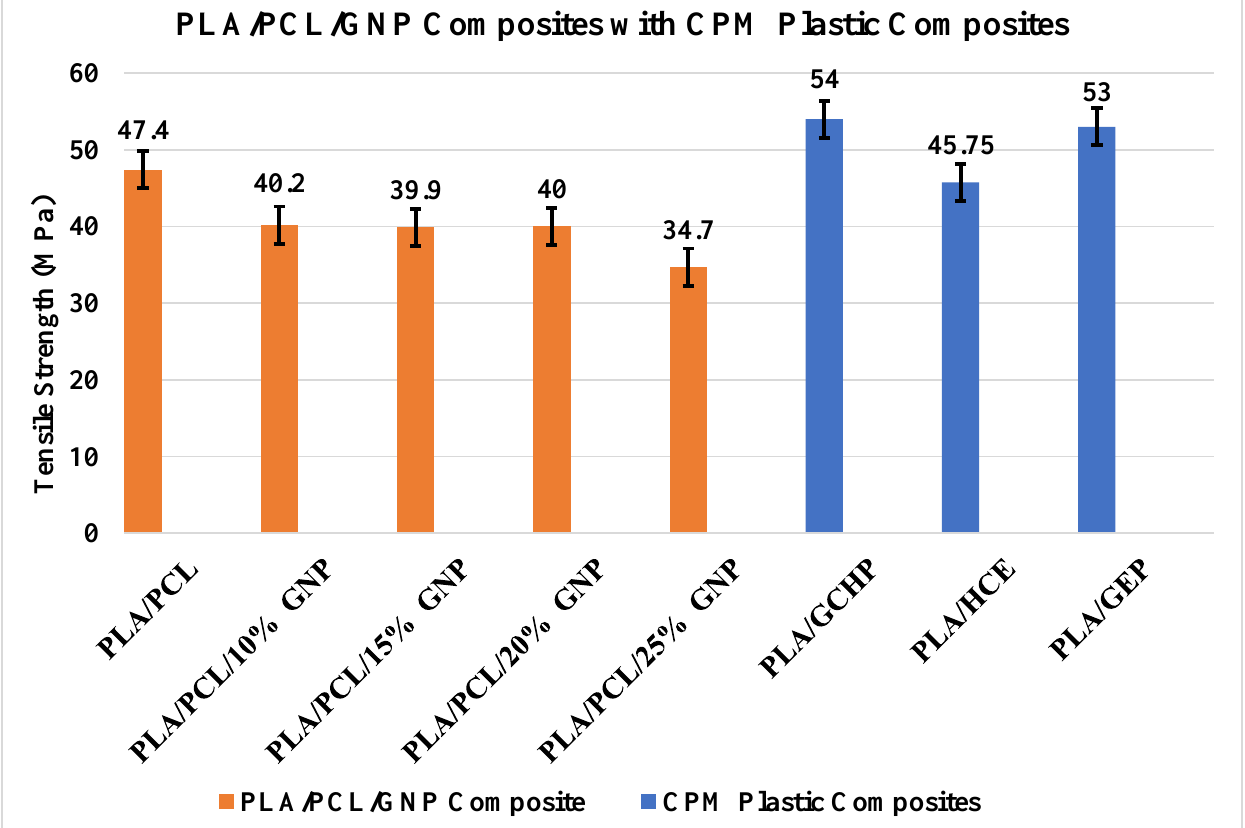
Figure 9. Results of PLA/PCL/GNP composites with CPM plastic composites.